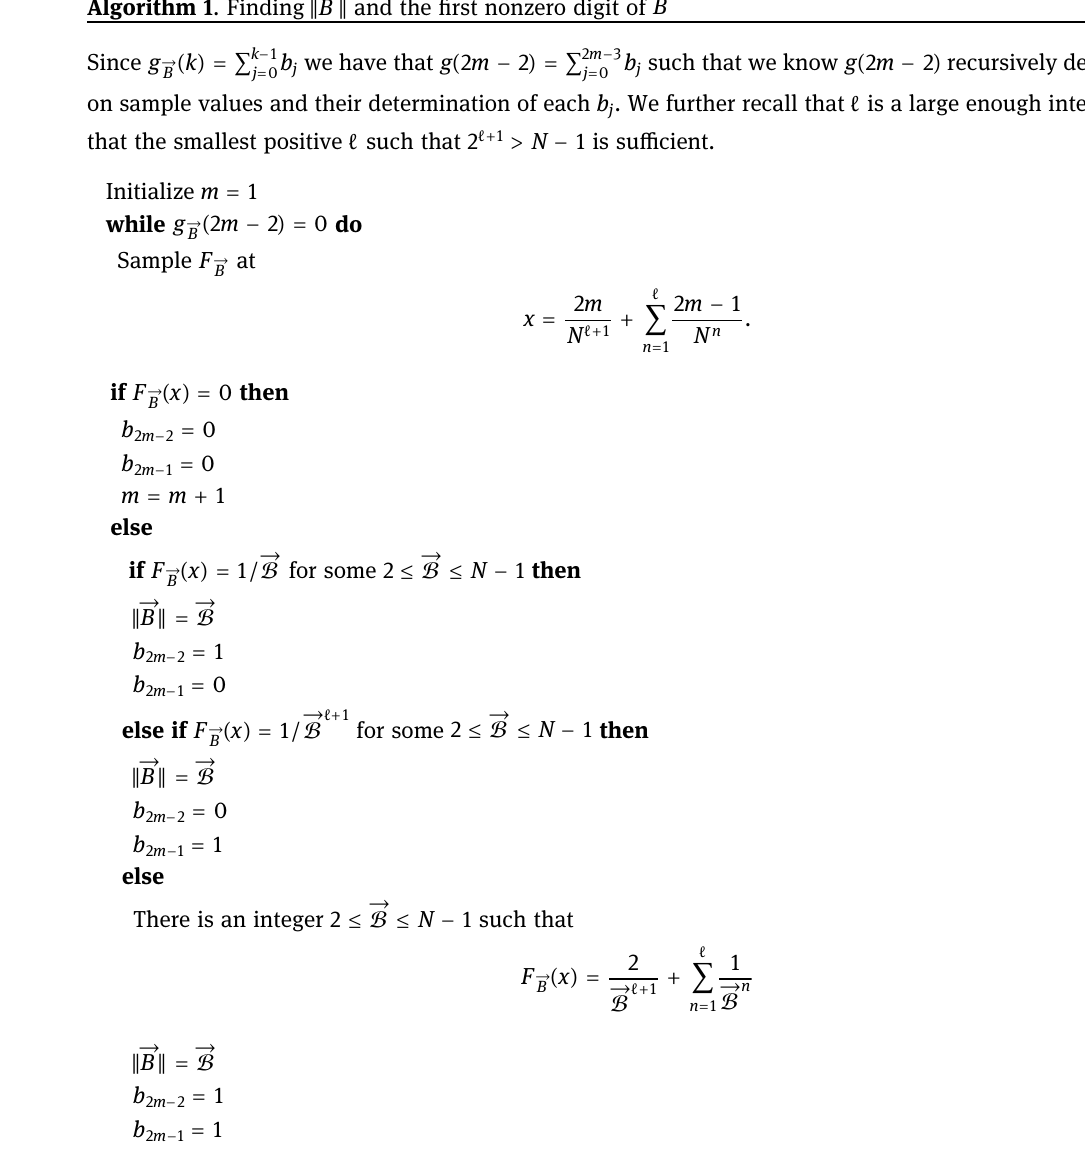
Algorithm 1 . Finding